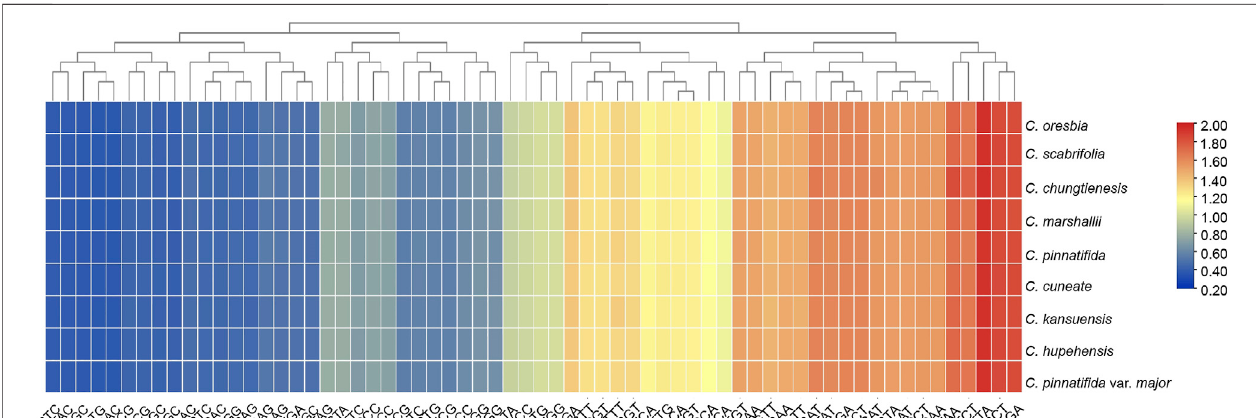
FIGURE 2 | Heatmap analysis of relative synonymous codon usage (RSCU) values among the 9 species of Crataegus.